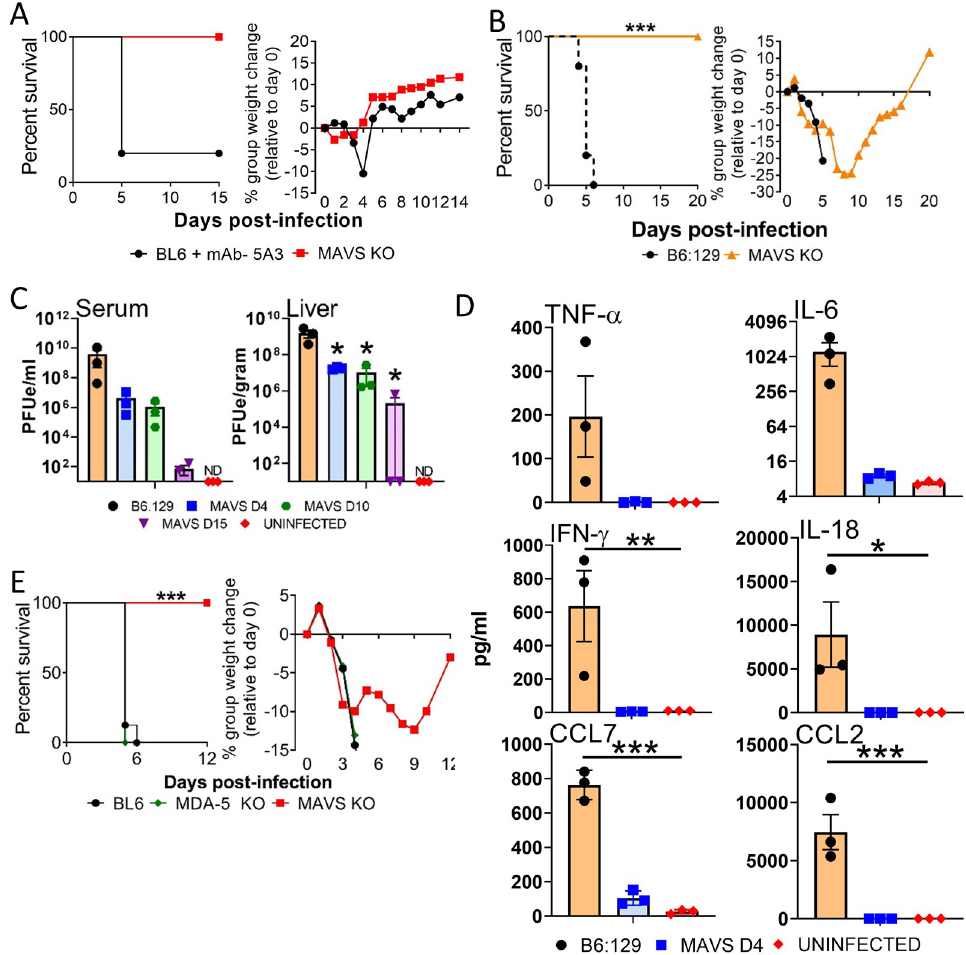
Fig 1. MAVS KO mice with IFN-I signaling blocked are protected against lethal infection by CCHFV. A. C57BL/6 mice or MAVS KO mice (n = 5/group) were infected with CCHFV and survival and weight loss were monitored and plotted using Prism software. Only WT mice were treated with MAb-5A3 24h after infection to block IFN-I. IFN-I was not blocked by antibody in the MAVS KO mice. B . B6.129 or MAVS KO mice (n = 6/group) were infected with CCHFV and both groups treated 24 h post-infection were treated with mAb-5A3. Survival and weight loss were monitored for 20 days and plotted using Prism software. Survival significance was determined by log-rank analysis; ��� p < 0.0001. C. Viral RNA in serum and liver was examined on day 4, 10 and 15 by RT-qPCR (n = 3 per group). Mean titers +/- SEM of the estimated PFUs (PFUe) were graphed. The dashed black line denotes limit of detection. Statistical significance was determined by one-way ANOVA; � p < 0.05. D. Monocyte chemoattractants and inflammatory cytokines were measured from the serum (n = 3 per group) of CCHFV infected mice on day 4 using a multiplex system. Statistical significance compared to uninfected controls was determined by one-way ANOVA; � p < 0.05, ��� p < 0.001. E. C57BL/6, MDA5 KO or MAVS KO mice (n = 8 per group) were infected with CCHFV and 24 h post-infection were treated with MAb-5A3. Survival and weight loss were monitored for 20 days. Significance determined by log-rank analysis (p <